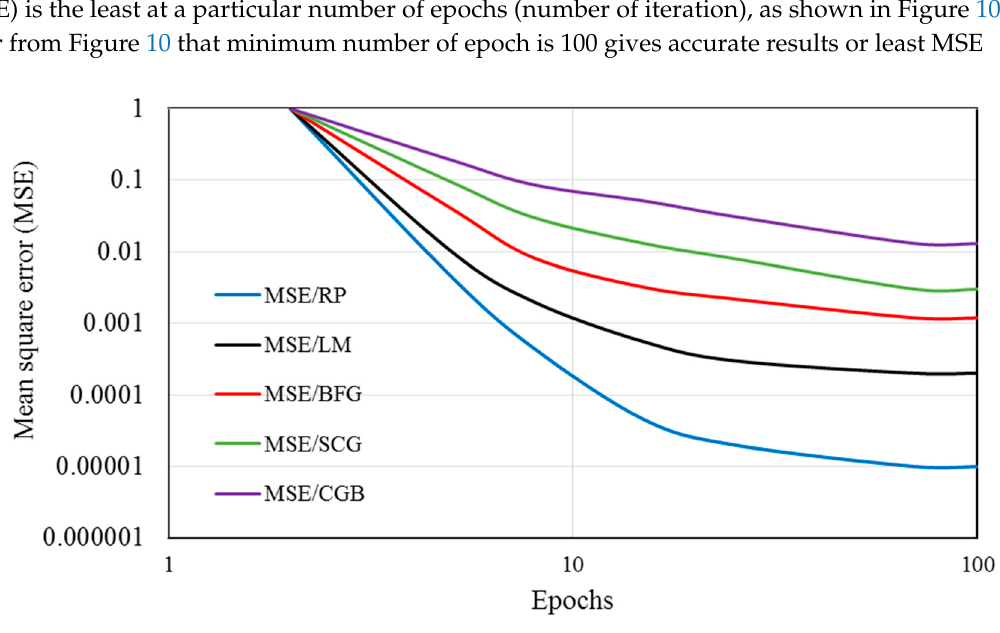
Table 3. Input / Output parameters for training and testing of BCC configuration.